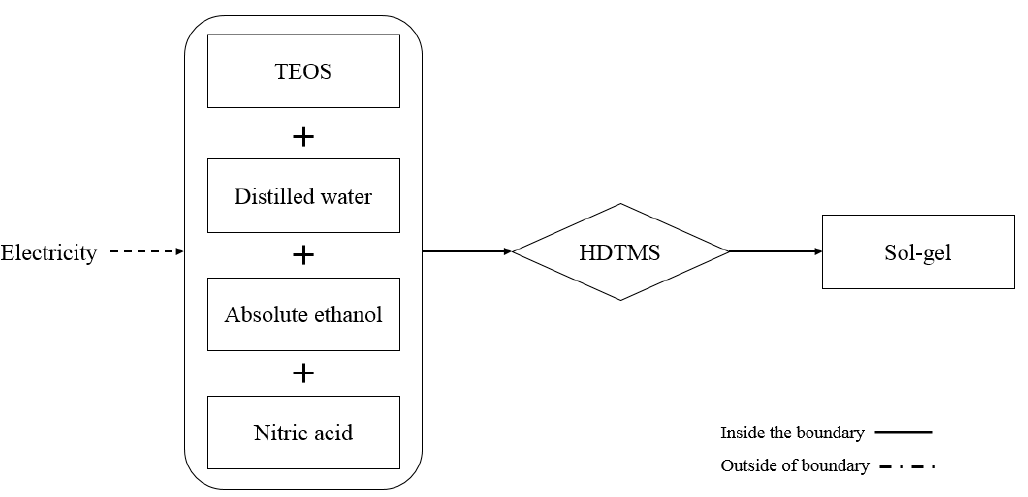
Figure 2. Sol-gel coating production at lab-scale. TEOS: tetraethyl orthosilicate, HDTMS: Hexadecyltrimethoxysilane.